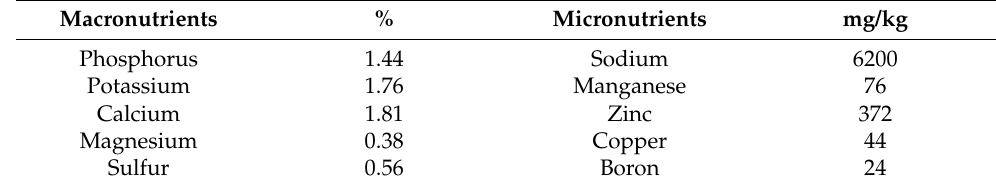
Table 1. Mineral composition (‘as is’ basis) of black soldier fly ( Hermetia illucens ) larvae frass.